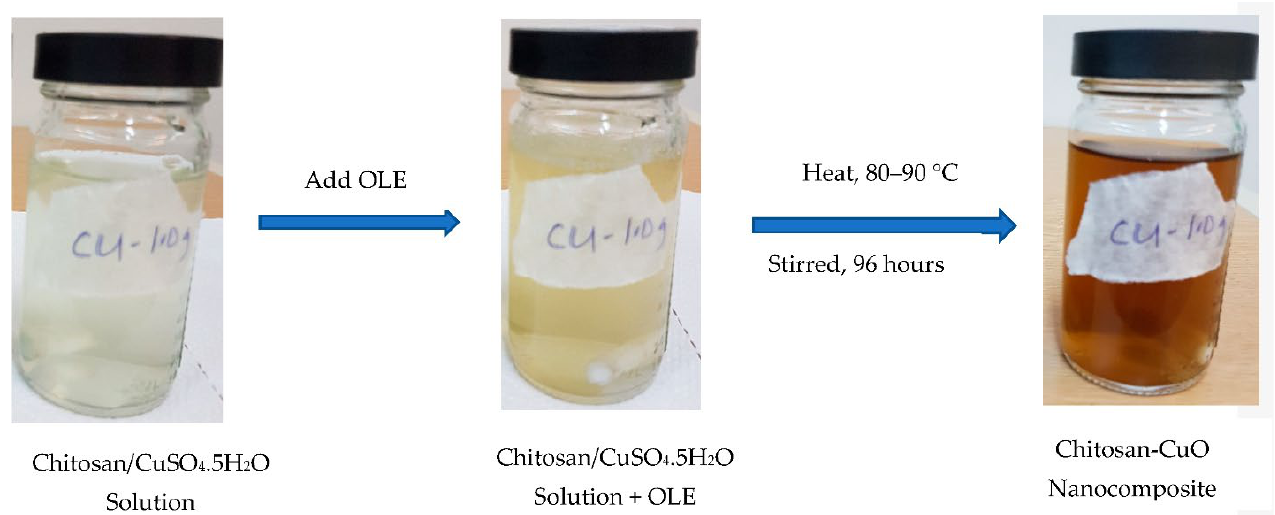
Figure 1. Schematic representation of biogenic in situ preparation of CH − CuO nanocomposite.